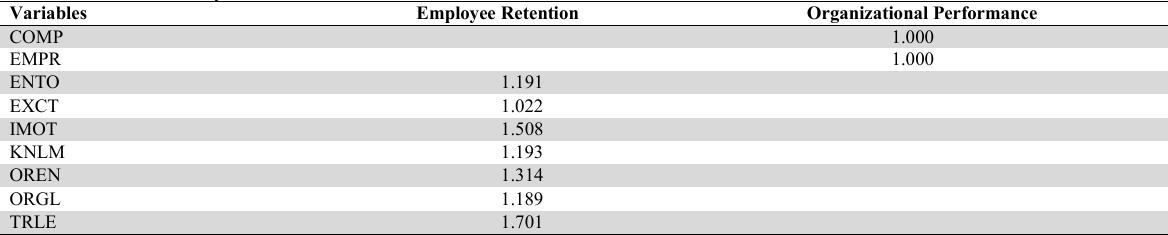
Lateral multicollinearity evaluation Variables